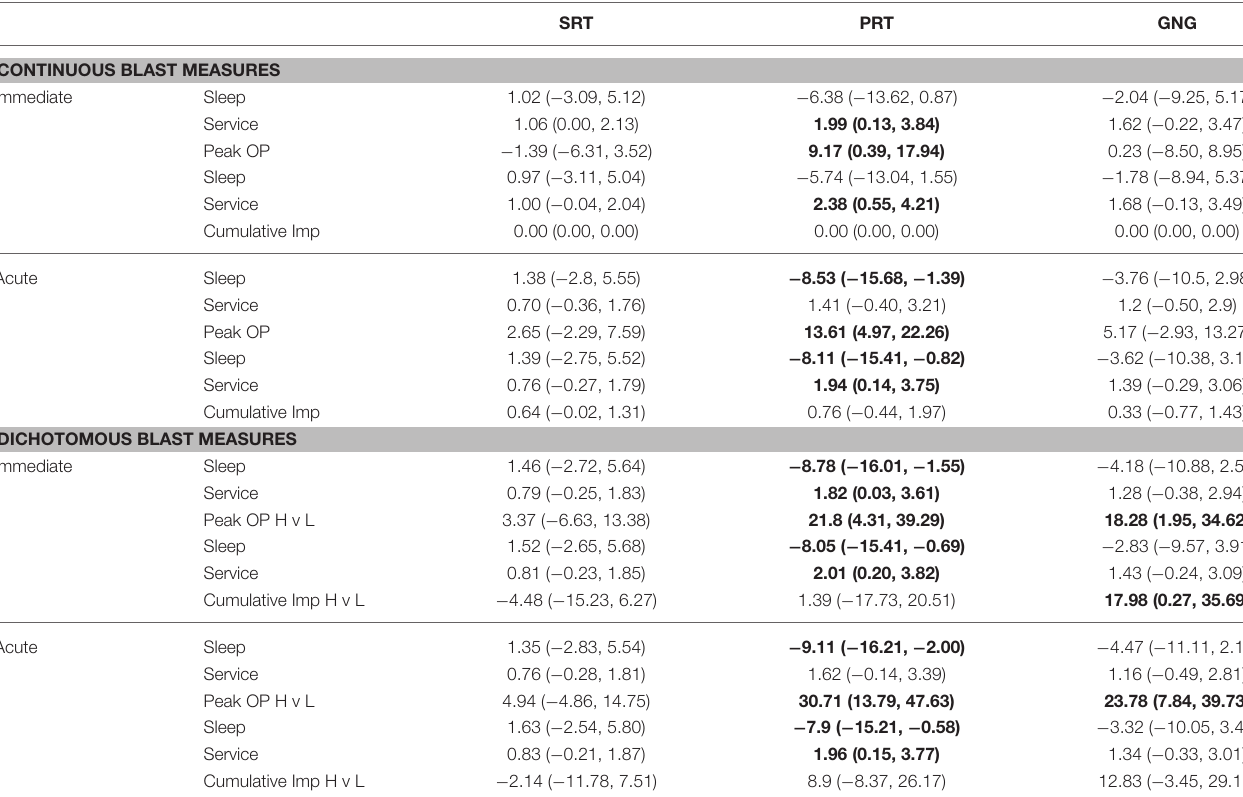
TABLE 2 | Multiple regression estimates (95% CI) for models assessing blast measures (continuous and dichotomized) and Immediate and Acute performance change by DANA subtests. SRT PRT